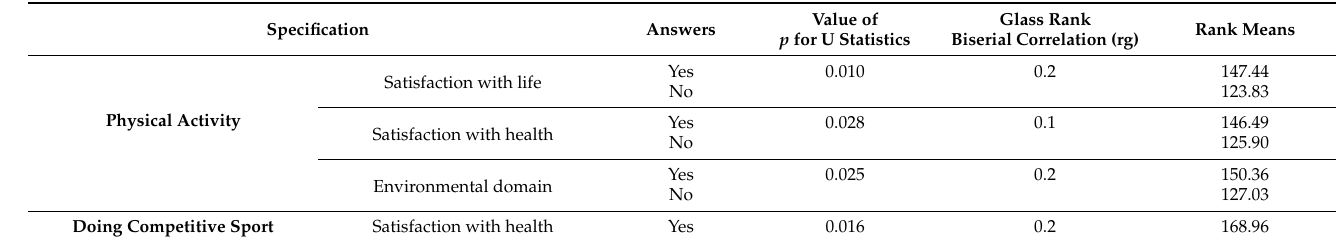
Table 4. Satisfaction with life, health, and particular domains of quality of life (WHOQOL-BREF) of female students by participation in physical recreation and sports (U test,